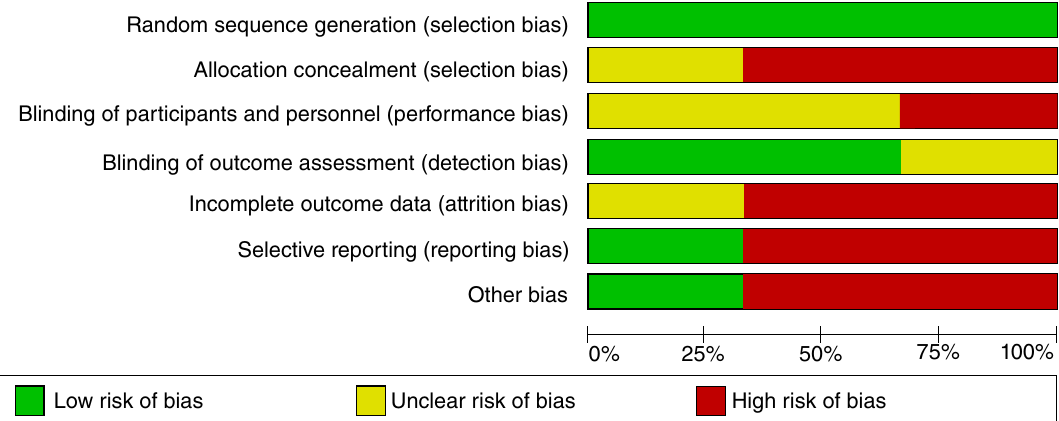
Figure 2. Risk of bias graph: review authors’ judgements about each risk of bias item presented as percentages across all included studies.